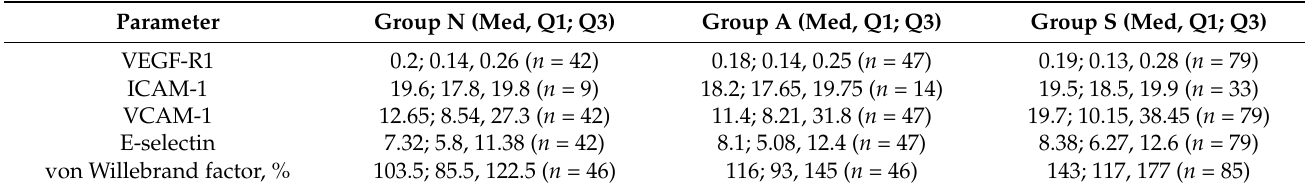
Table 3. Group-wise statistics for the endothelial dysfunction parameters.